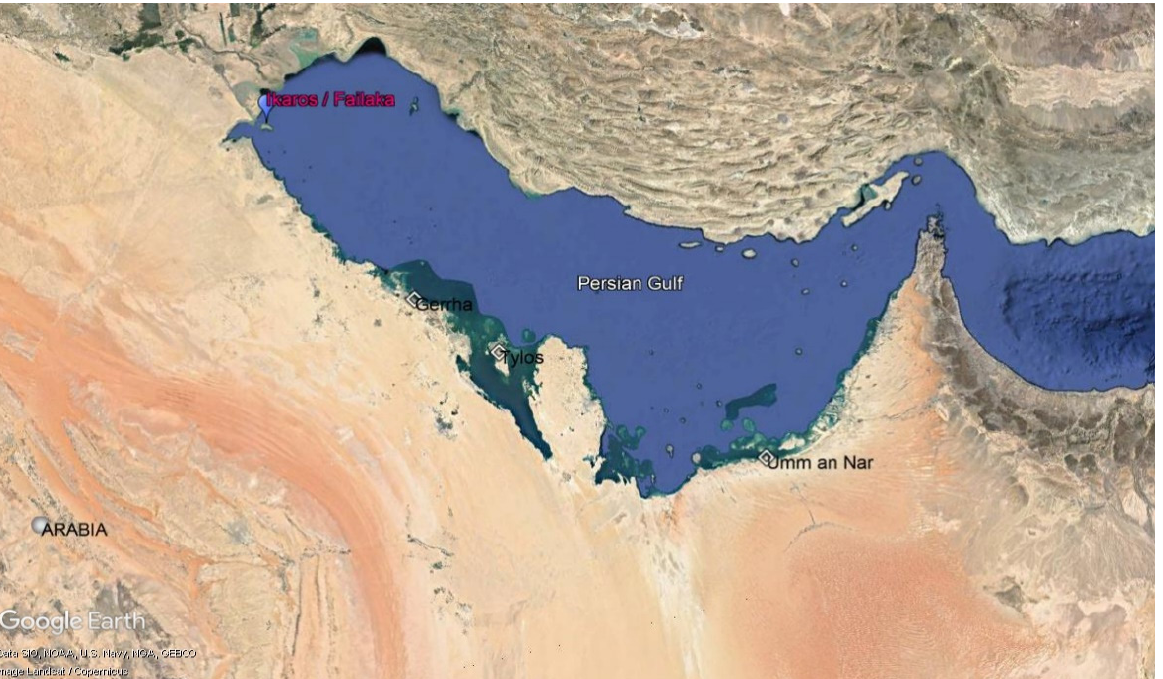
Figure 1. Map of the Persian Gulf showing the position of Ikaros/Failaka. The map was created by the author using Google Earth Pro maps.